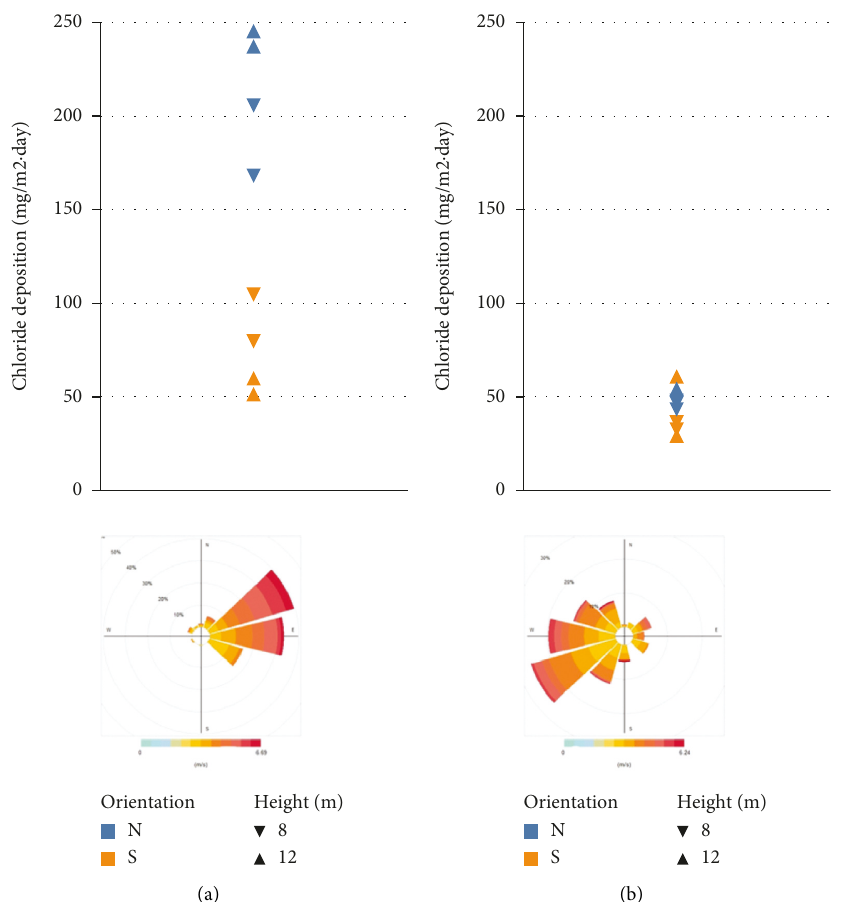
Figure 7: Results of the localized tests: first study period (a). Second study period (b).